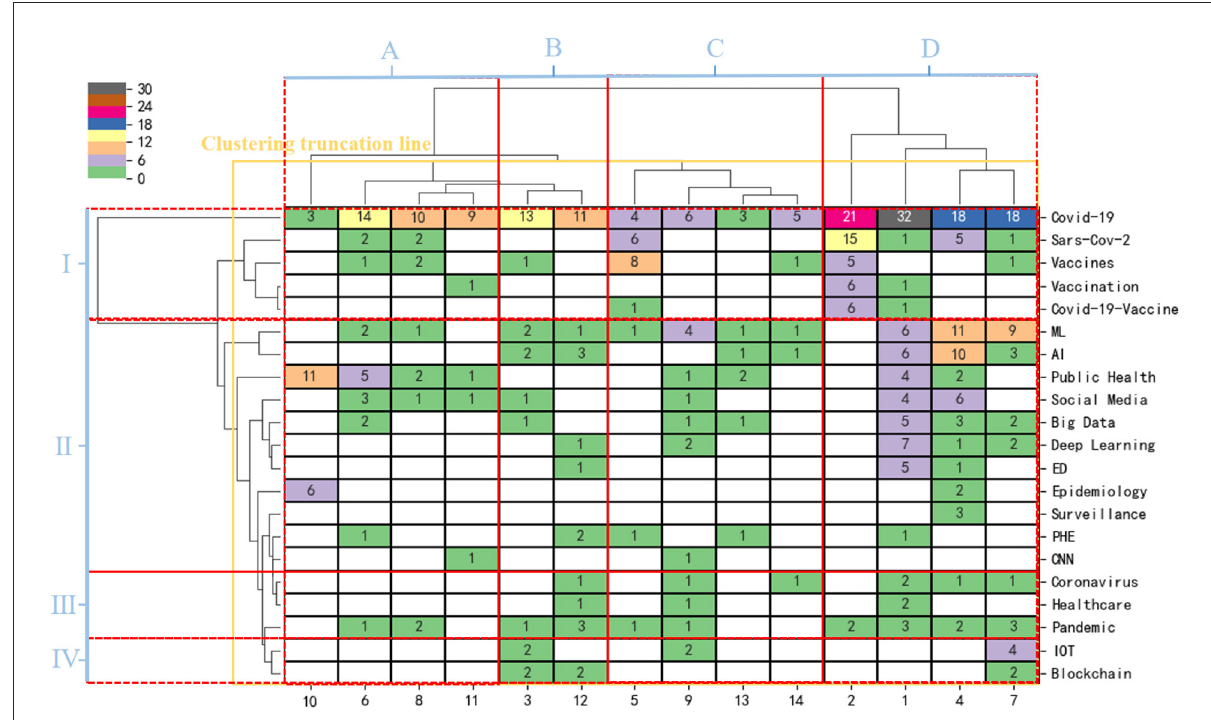
FIGURE7 Mapping knowledge domain of system clustering pedigree tree based on the two-module matrix of journals-keywords. ML, machine learning; AI, artificial intelligence; ED, emergency department; PHE, public health emergency; CNN, convolutional neural network; IOT, internet of things.